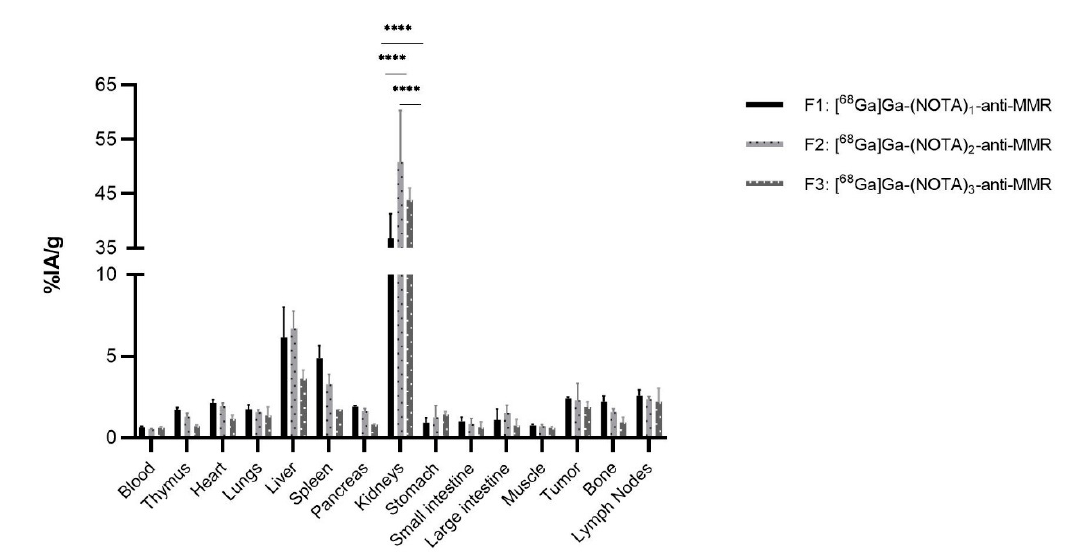
Figure 6. Ex vivo biodistributions analysis of [ 68 Ga]Ga-(NOTA) n -anti-MMR fractions in C57Bl/6 mice ( n = 3 per group), with a 3-LLR tumor (**** p < 0.001).